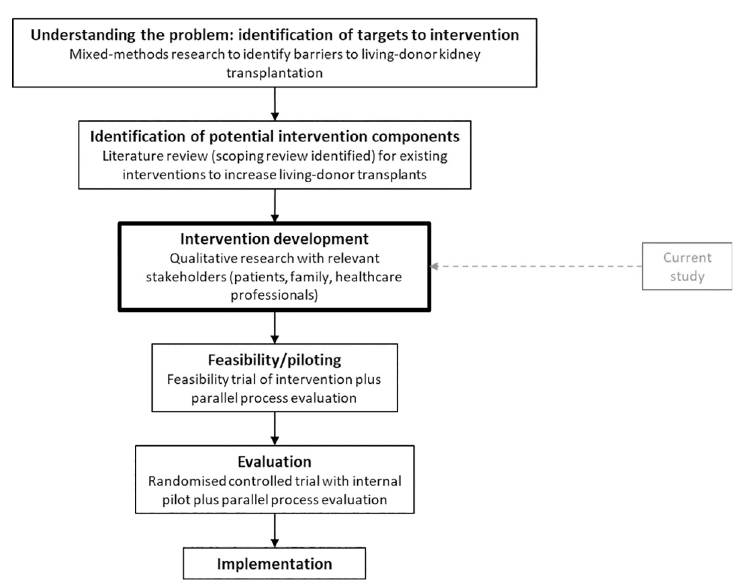
Fig 1. Flow chart illustrating programme of research.